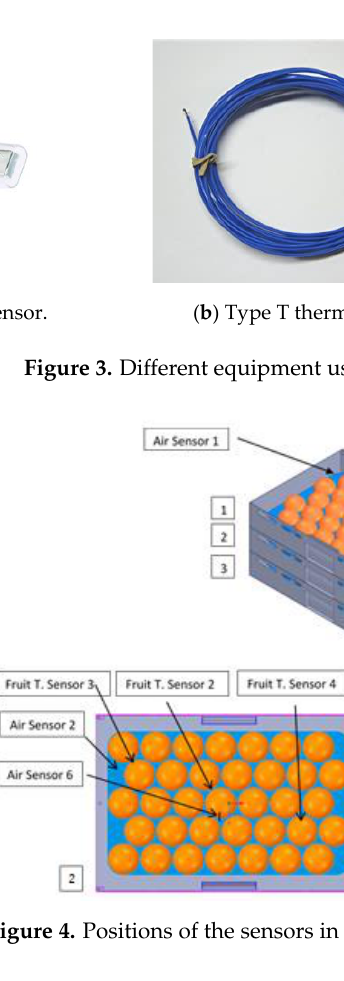
( a ) Vertical section dimensions. ( b ) Packaging box location. Figure 5. Cold Chamber: a) Main dimensions; b) Picture from the beginning of an experiment. Table 1. Properties of the materials. Density (kg/m 3 ) Thermal Conductivity (W/mK) Specific Heat (J/kgK)